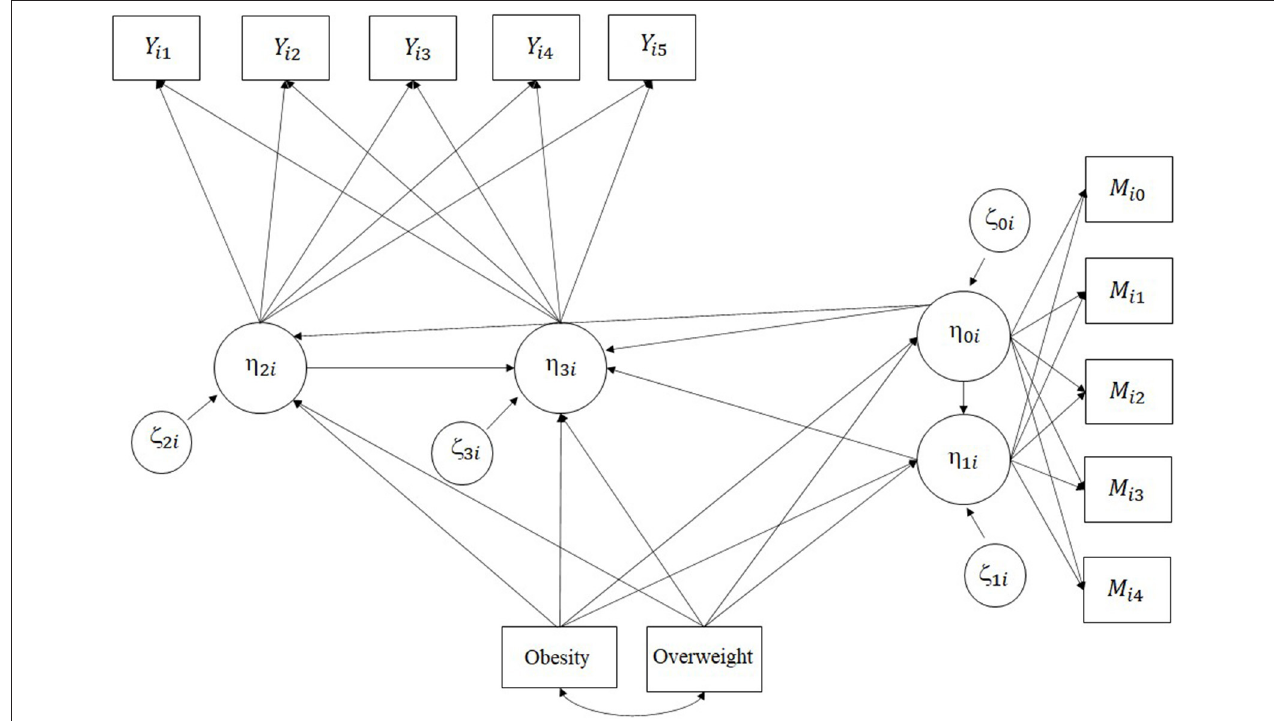
FIGURE 2 | PP-LGM for mediation